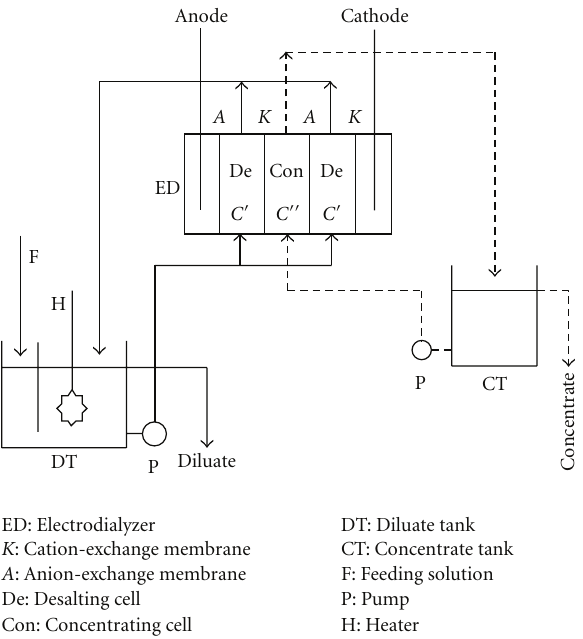
Figure 2: Electrodialysis process.